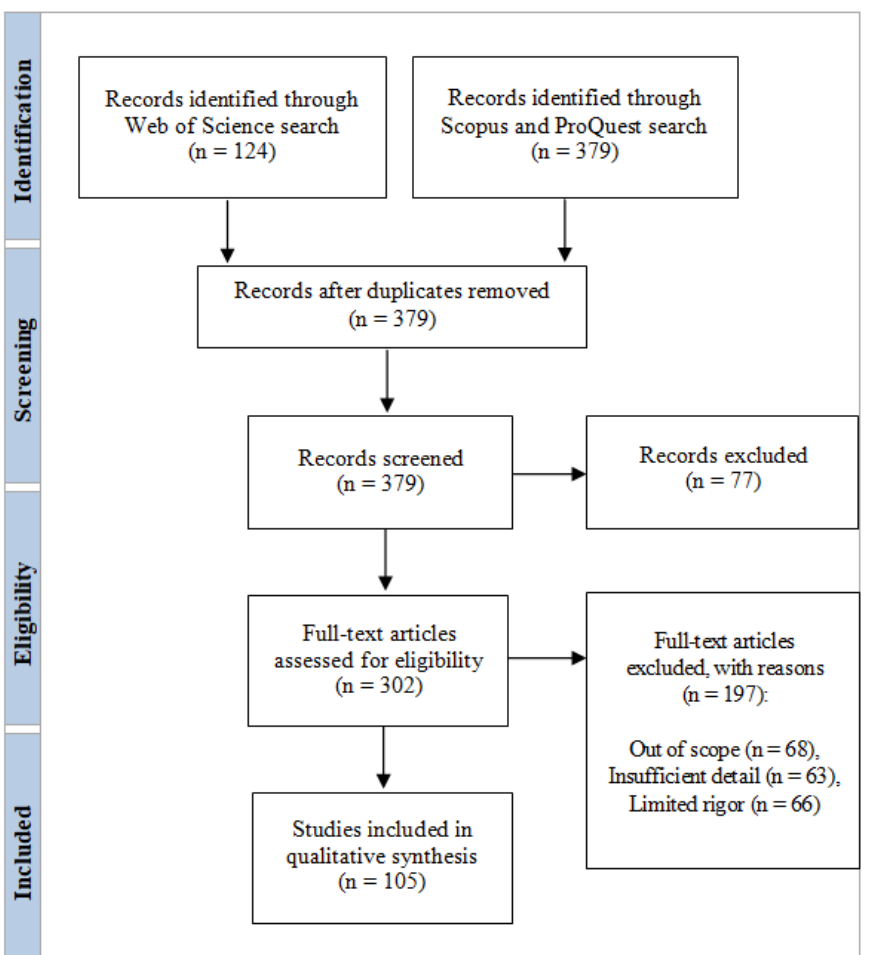
Figure 5. PRISMA flow diagram describing the search results and screening.